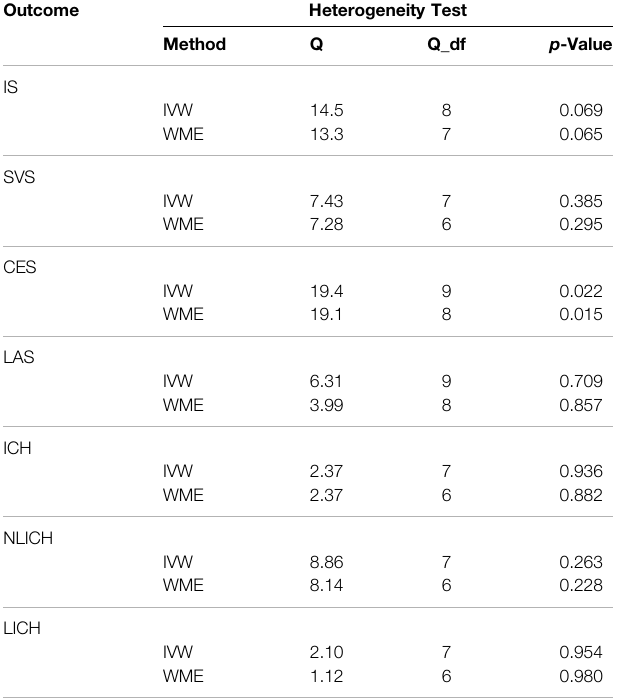
TABLE 1 | Heterogeneity tests in the causality of TIMP-3 and IS, ICH. Q = Cochran ’ s Q statistic; df = degrees of freedom. IVW = inverse-variance- weighted, WME = Weighted median estimation, IS = ischemic stroke, LAS = large vessel ischemic stroke, CES = cardioembolic ischemic stroke, SVS = small vessel ischemic stroke, ICH = intracerebral hemorrhage, NLICH = non-lobar intracerebral hemorrhage, LICH = lobar intracerebral hemorrhage.